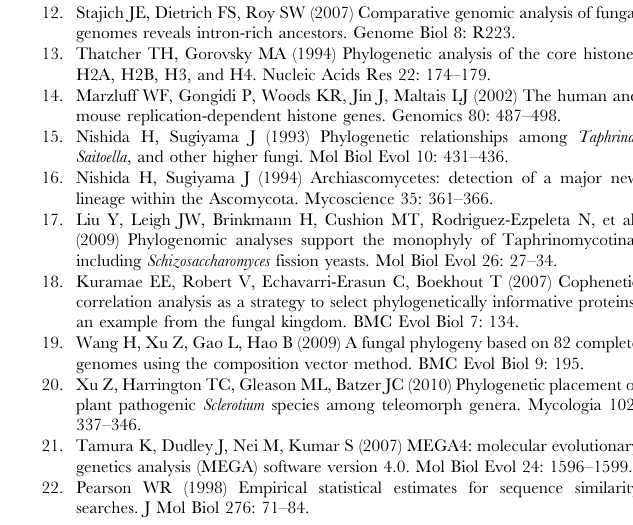
Figure S1 Alignment of fungal histone H2A proteins and the intron insertion site. The character ‘‘I’’ on the first row indicates the intron insertion site. Figure S2 Alignment of fungal histone H2B proteins and the intron insertion site. The character ‘‘I’’ on the first row indicates the intron insertion site. Figure S3 Alignment of fungal histone H3 proteins and the intron insertion site. The character ‘‘I’’ on the first row indicates the intron insertion site. Figure S4 Alignment of fungal histone H4 proteins and the intron insertion site. The character ‘‘I’’ on the first row indicates the intron insertion site.